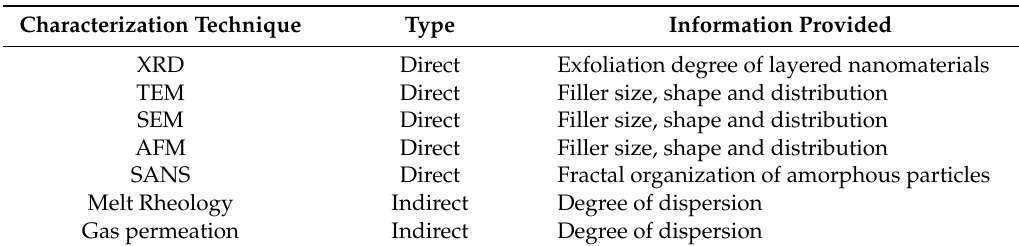
Table 2. List of conventional approaches to evaluate the dispersion of nanoparticles in solid matrices and the type of information